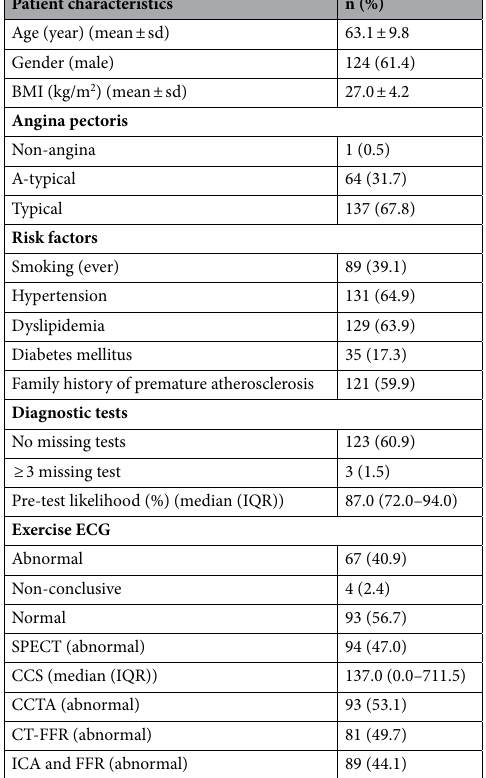
Table 1. Baseline and diagnostic test characteristics. Continuous variables are reported as means (standard deviation) or medians (interquartile range). Categorical variables are reported as number (%). BMI body